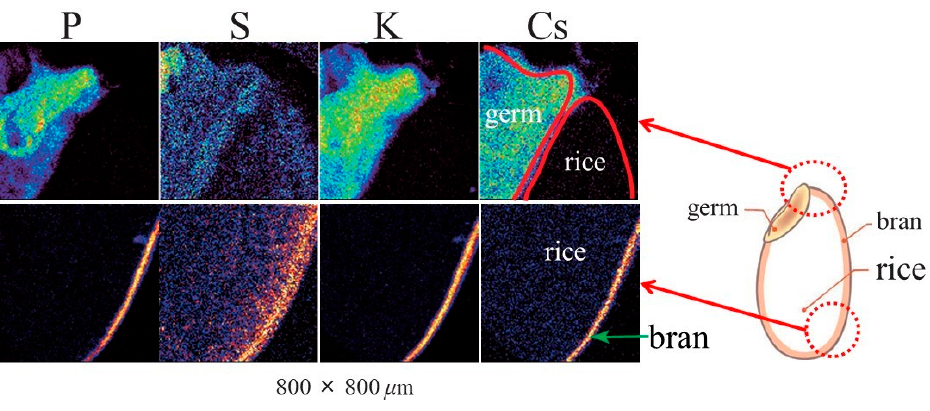
Figure 11. Distributions of elements in brown rice grains grown in soil containing cesium.